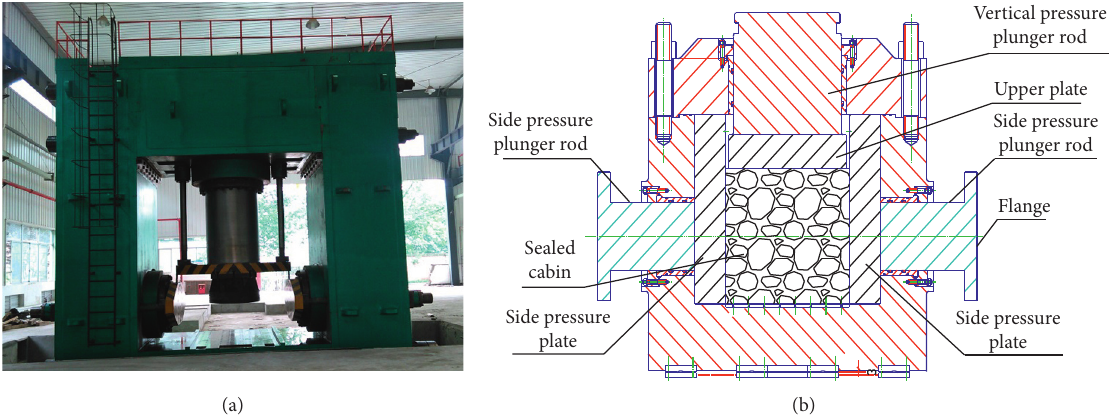
Figure 5: Mechanical loading system. (a) Frame-type mechanical loading system. (b) Loading mode of sealed